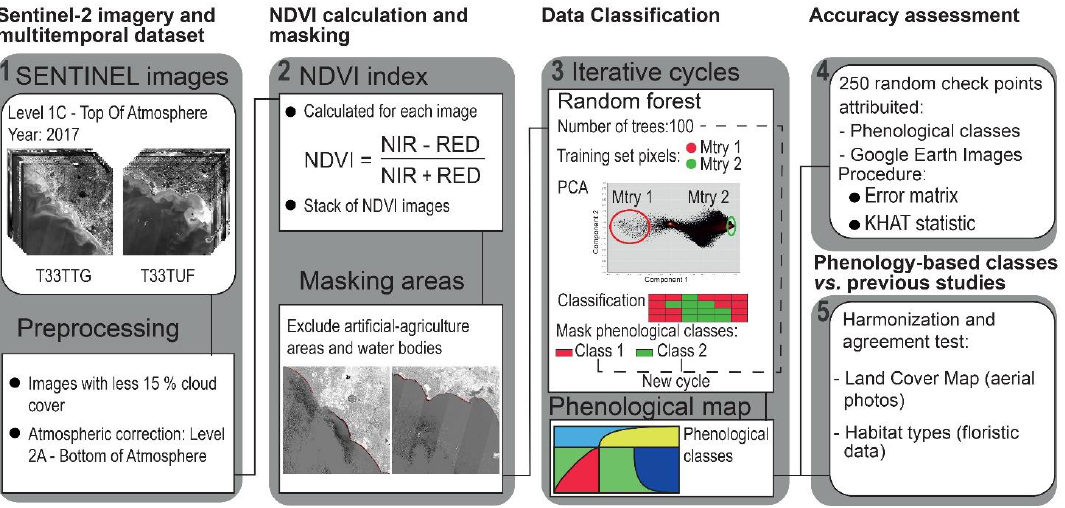
Figure 2. Workflow synthesizing the full mapping procedure of natural dune vegetation with Sentilnel-2 NDVI (Normalized Difference Vegetation Index) time series and Random Forest classification approach.